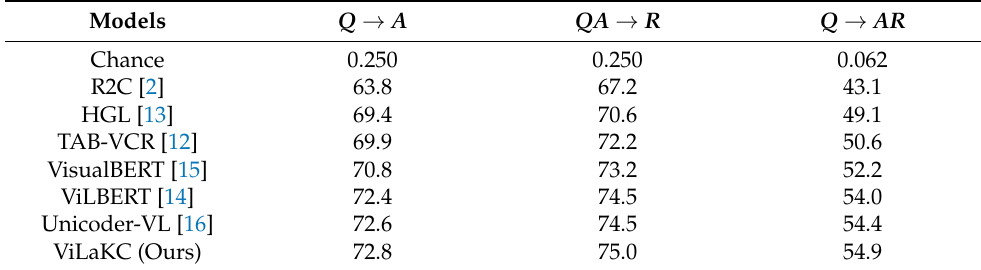
Table 4. Comparison with existing